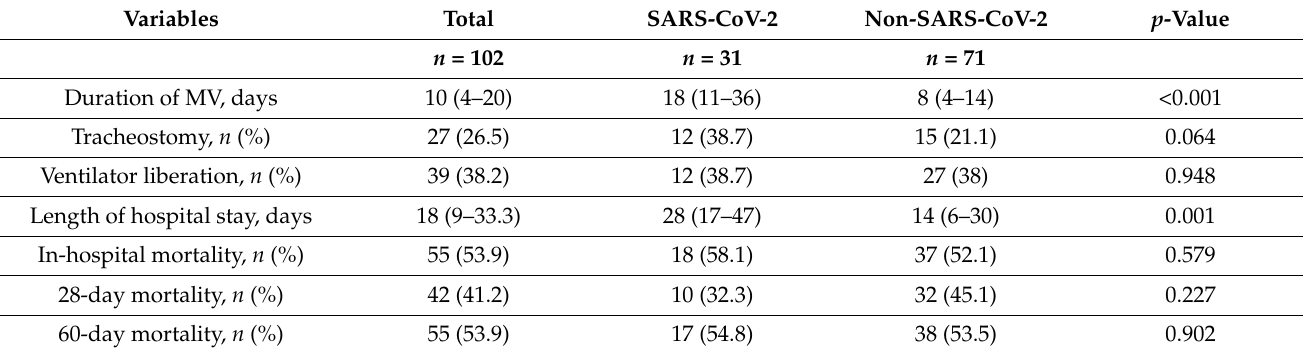
Table 3. Clinical outcomes of total, patients with SARS-CoV-2, non-SARS-CoV-2 respiratory